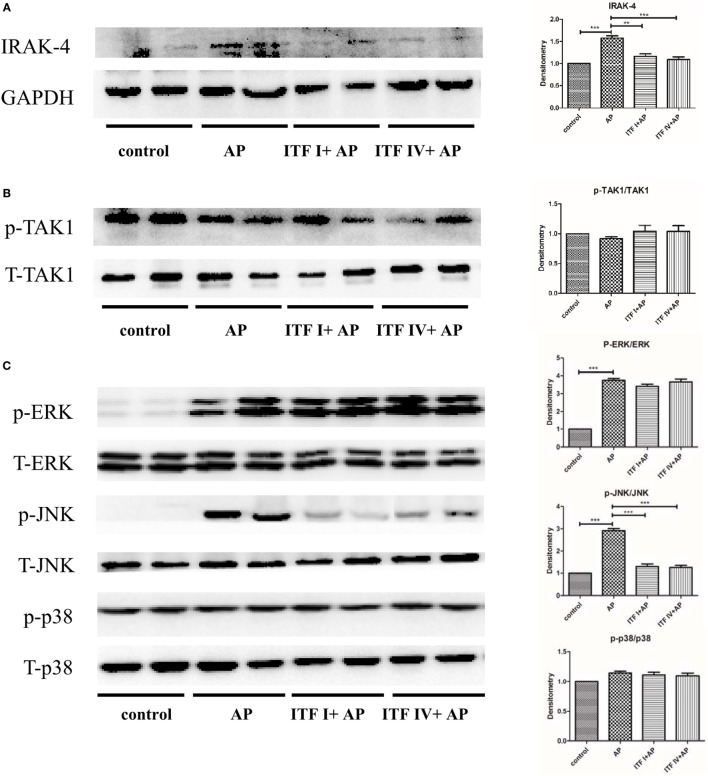
Effects of ITFs on AP-mediated activation of MAPK and NF-κB pathways in the pancreas. Mice were fed with 5% ITF I or ITF IV supplemented diets for 72 h before AP induction by caerulein. The activation/expression of pancreatic IRAK4 (A), p-TAK1 (B), p-ERK, p-JNK, p-p38 (C), and NF-κB p-p65 (D) were examined by Western blot. Data shown are means ± SEM. **P < 0.01 and ***P < 0.001. AP, acute pancreatitis; ERK, extracellular signal-regulated kinase; IRAK, IL-1 receptor associated kinase; ITF, inulin-type fructans; JNK, c-Jun N-terminal kinase; MAPKs, mitogen-activated protein kinases; NF-κB, nuclear factor kappa-light-chain-enhancer of activated B cells; TAK, TGF-β activated kinase.